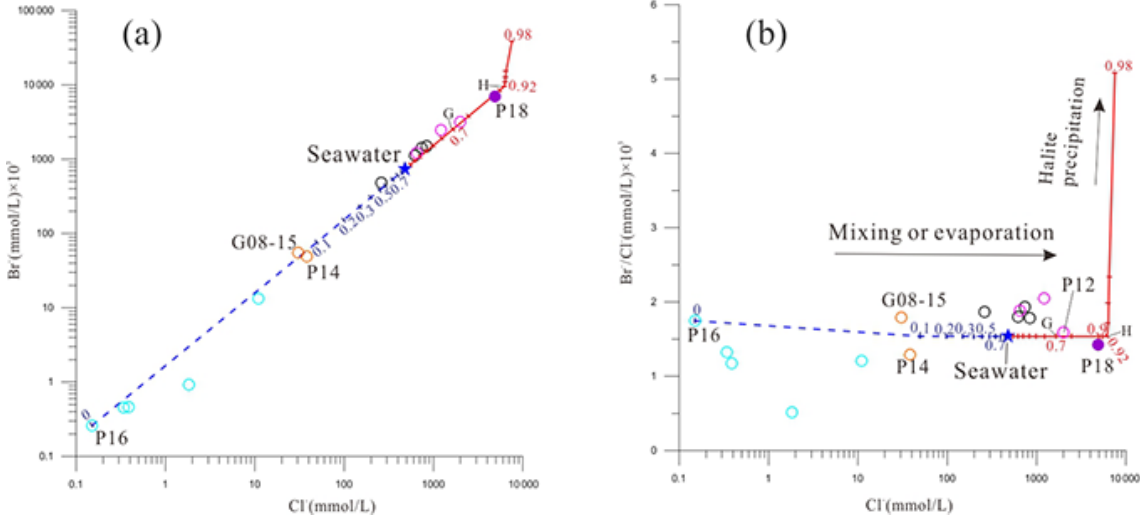
Figure 7. Relationship between the chloride and bromide contents in water samples. Symbols used are the same as in Fig. 6.